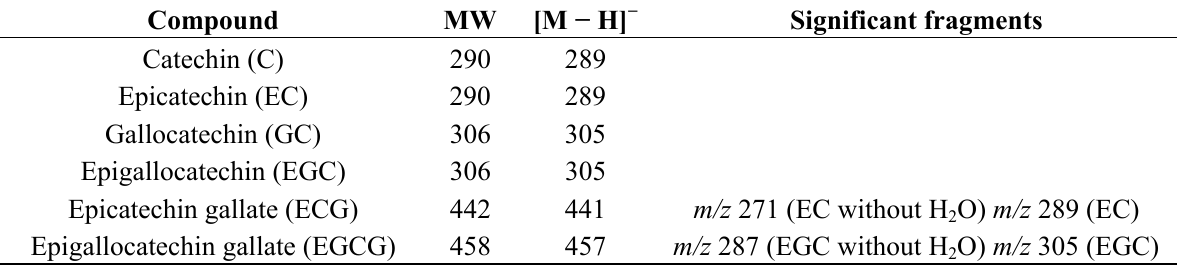
Table 1. Molecular ions and some significant fragments of main catechins presented in